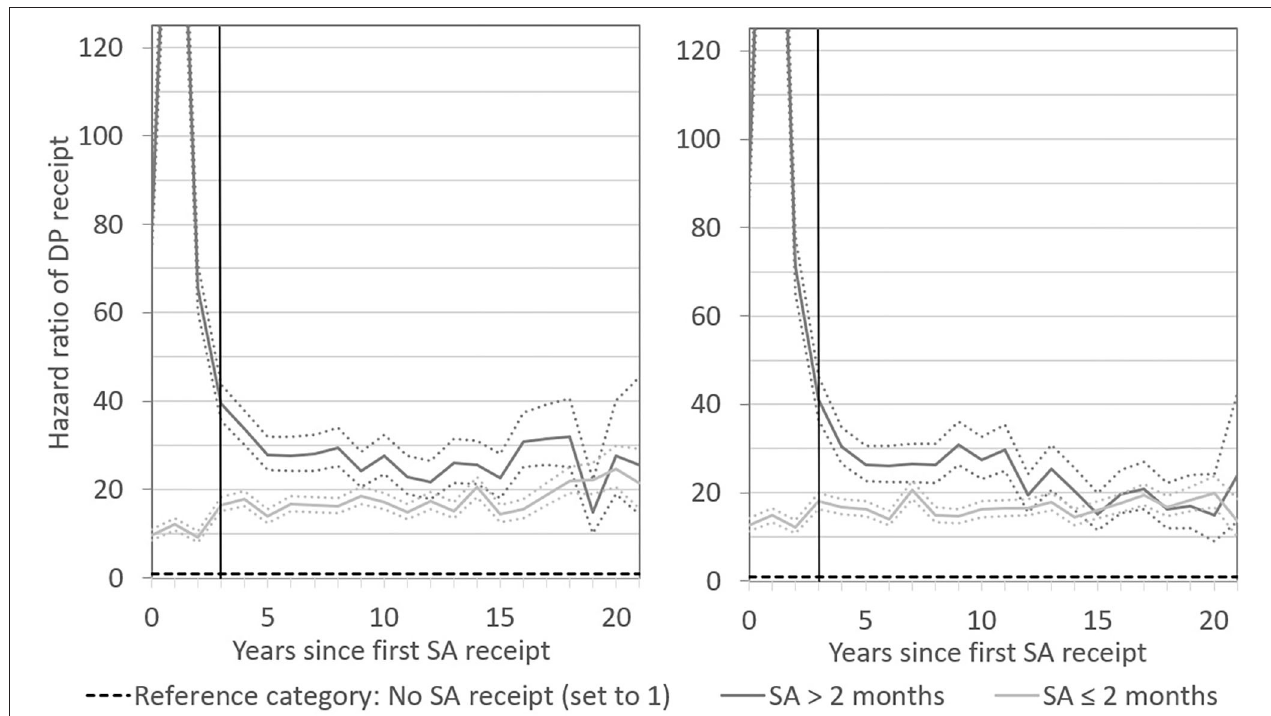
FIGURE 3 | Hazard ratios of DP receipt after first SA receipt by length of SA receipt in the long term. Results for men are presented in the left-hand panel and for women in the right-hand panel. Numbers reported are unadjusted and adjusted estimates with 95 percent confidence intervals. Numbers reported are adjusted estimates with 95 percent confidence intervals. The vertical line in each panel indicates the shift between short- and long-term follow-up at year